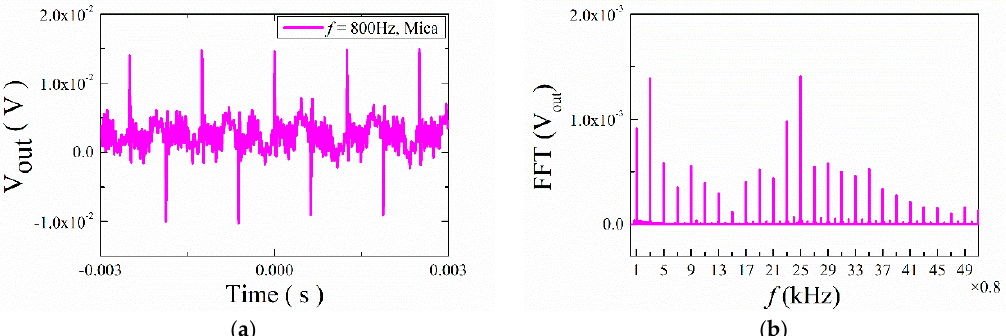
Figure 8. ( a ) Waveforms of ME voltage in time domain for the ME structure with mica trestles at 0.8 kHz; ( b ) the FFT spectral pattern for ME voltage.